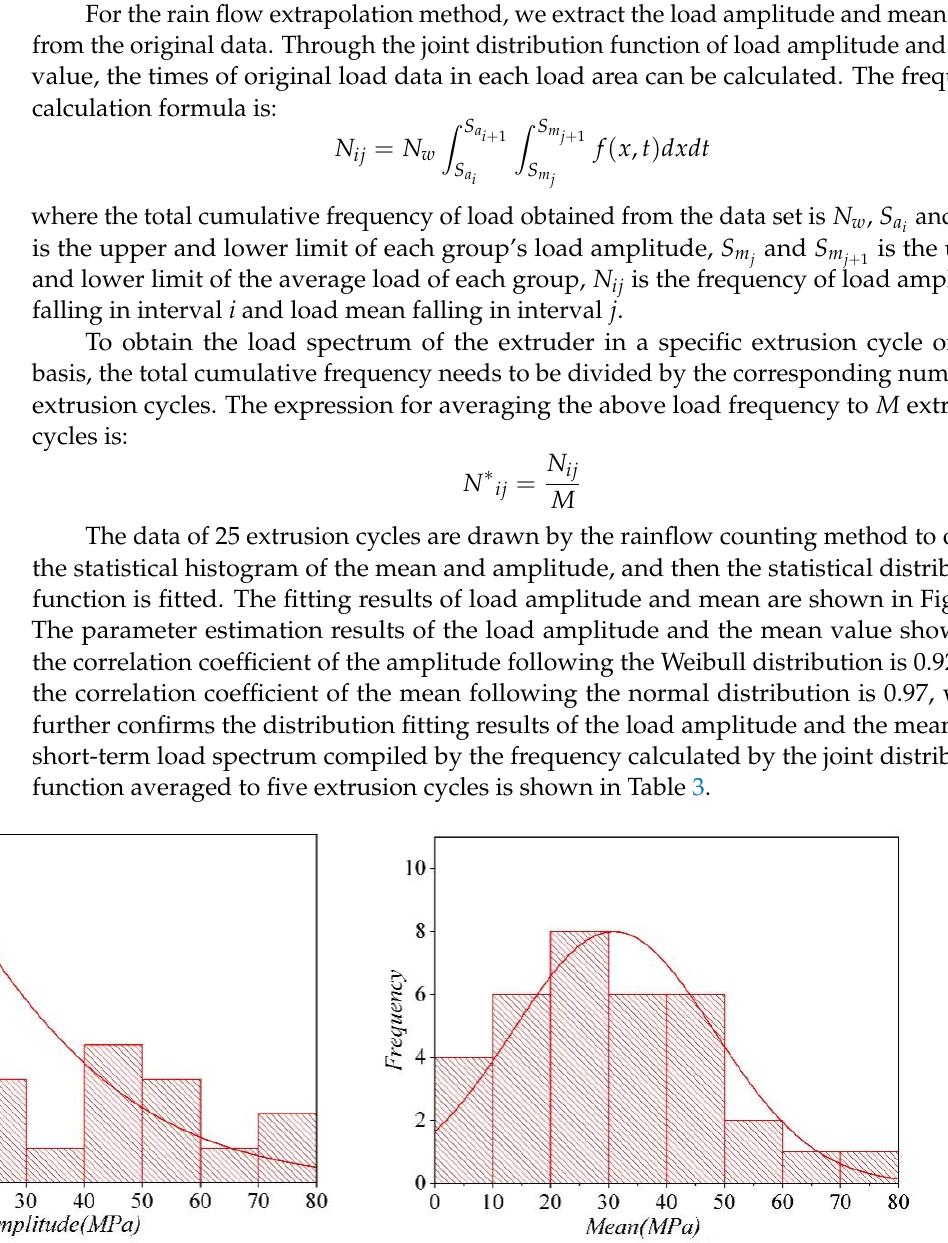
Table 2. Scale factor for the grade division of load cycle amplitude and mean.